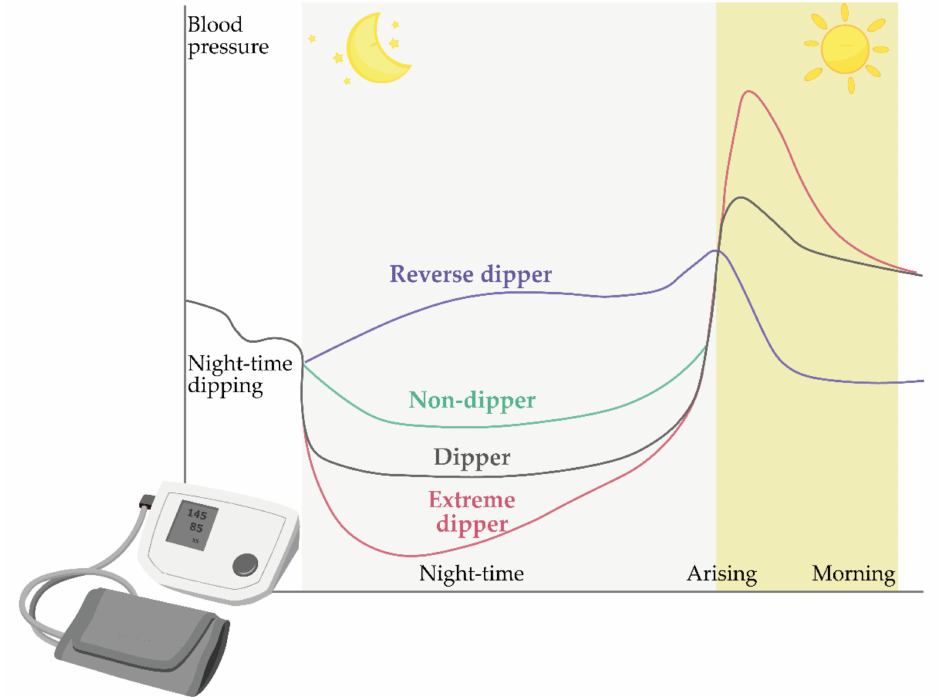
Figure 5. Schematic representation of the dipping status of patients during the night, including dippers (black), non-dippers (green), extreme dippers (purple), and reverse dippers/risers (violet). The image was created with the Adobe Illustrator CC (Version 23.0.1.; Adobe Inc., 2019)